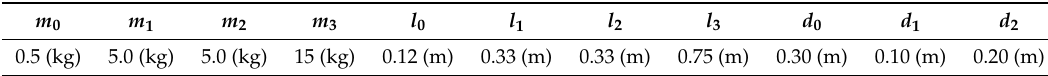
Figure 1. ( a ) BHR6 humanoid robot; ( b ) the simplified model with the similar physical properties of BHR6. Table 1. Parameters of the simplified